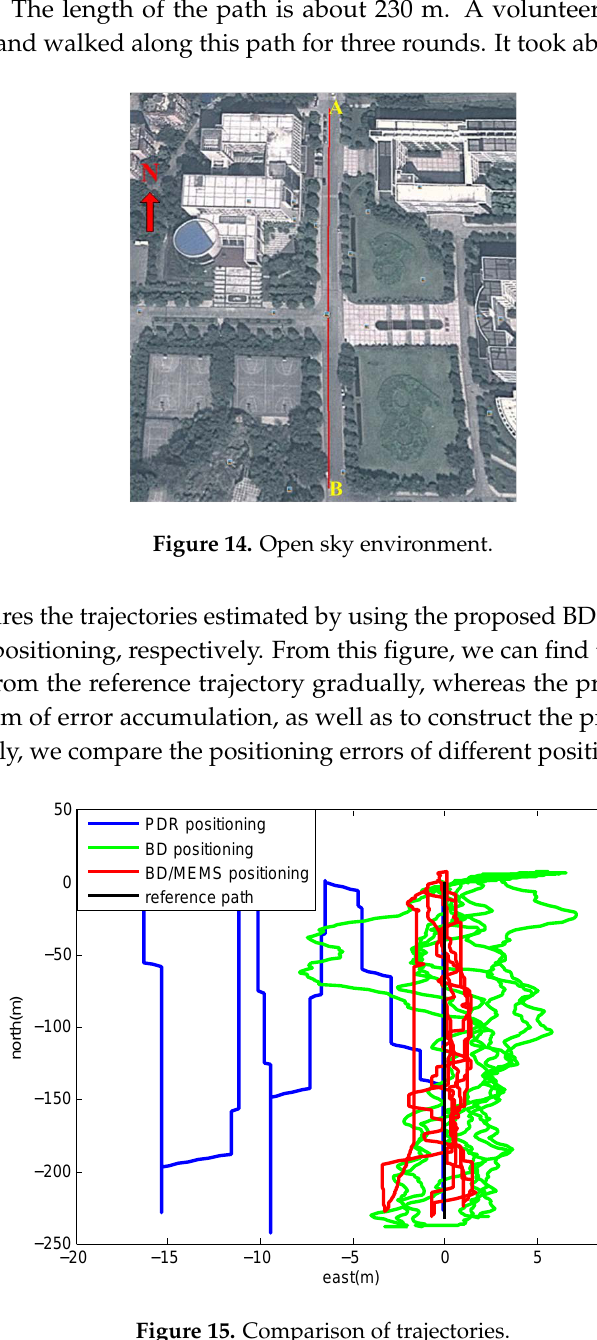
Figure 15. Comparison of